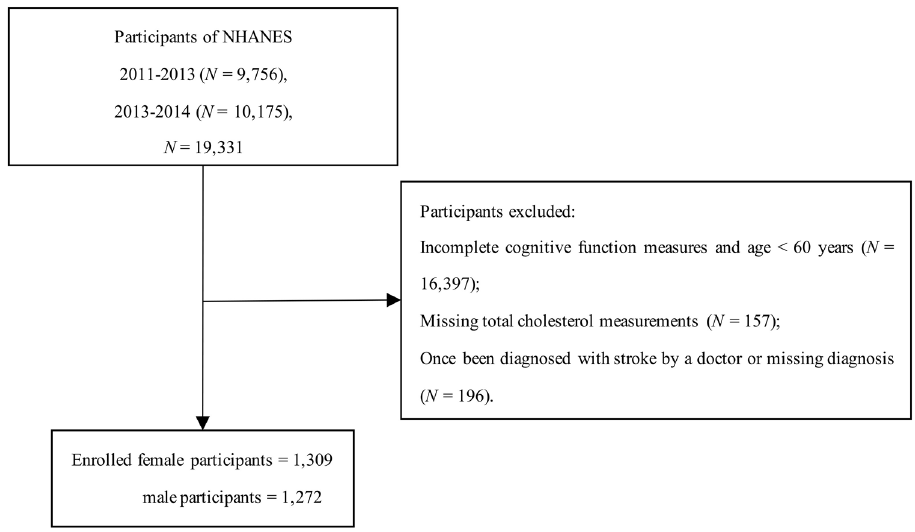
Figure 1. Flow chart outlining the process for selecting participants.